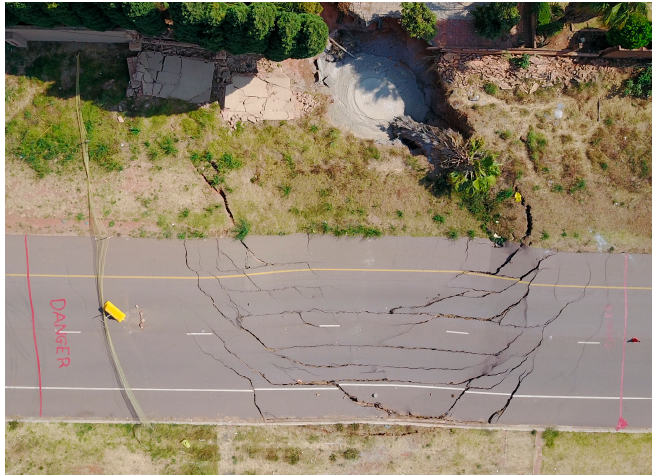
Figure 3. A sinkhole, and associated tension cracks, that resulted in road closure in Gauteng, South Africa in 2018. The sinkhole is in the process of being rehabilitated and has been filled with concrete. (photo credit: Dilnaaz Patel).